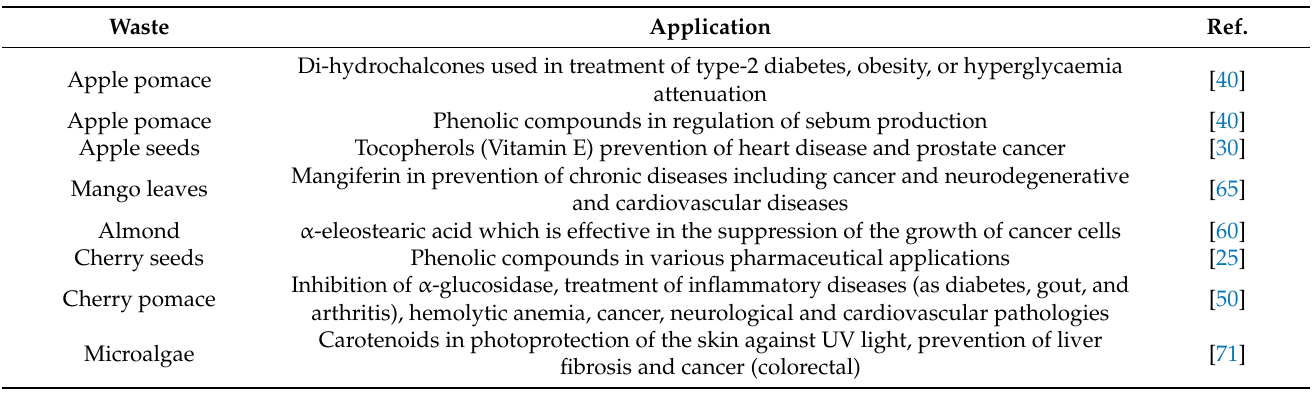
Table 12. Summary of different pharmaceutical applications of bioactive compounds and pigments from microalgae and food